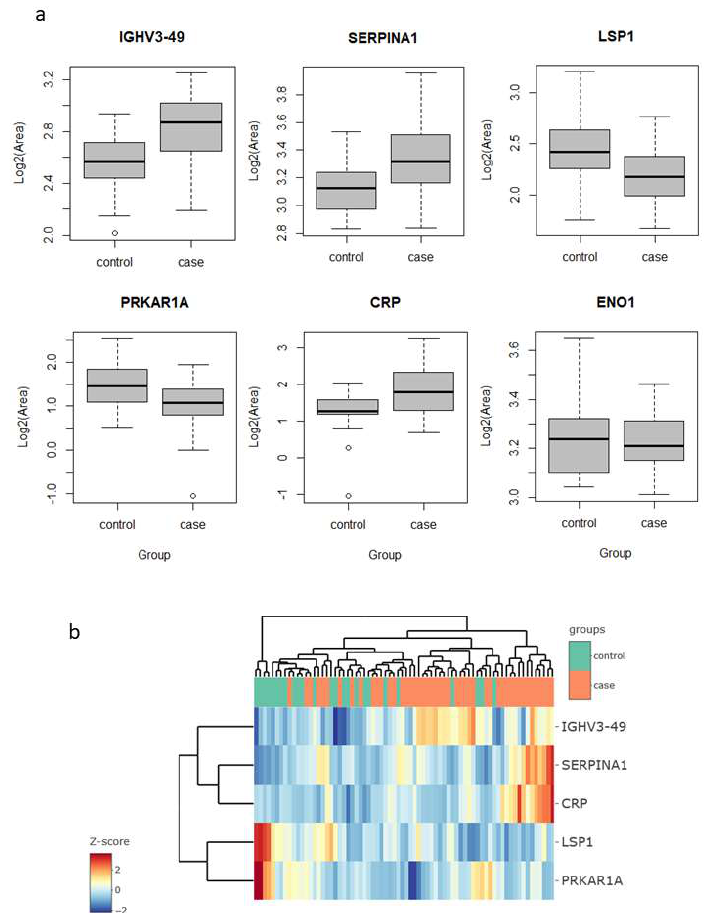
Figure 1. Differential abundance of selected proteins in the sputum proteomes of cases vs. control groups. ( a ) Normalized abundance levels of IGHV3−49, SERPINA1, LSP1, PRKAR1A, CRP, and ENO1. ( b ) Heatmap of the five proteins showing differential abundance in sputum. IGHV3−49, immunoglobulin heavy variable 3−49; SERPINA1, serpin family A member 1; LSP1, lymphocyte specific protein 1; PRKAR1A, protein kinase cAMP-dependent type I regulatory subunit Alpha; CRP, C−reactive protein and protein kinase; ENO1, enolase 1.